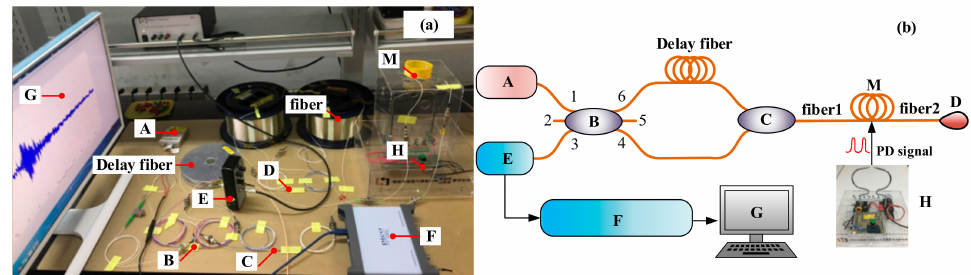
Figure 3. Optical fiber PD detection system (OFPDS). ( a ) Experimental device diagram and ( b ) the experimental schematic diagram. A—Laser, B—3 × 3 Coupler, C—2 × 1 Coupler, D—1 × 2 Coupler, E—Detector, F—Data acquisition (DAQ) card, G—Personal computer (PC), H—PD simulator device, M—optical fiber